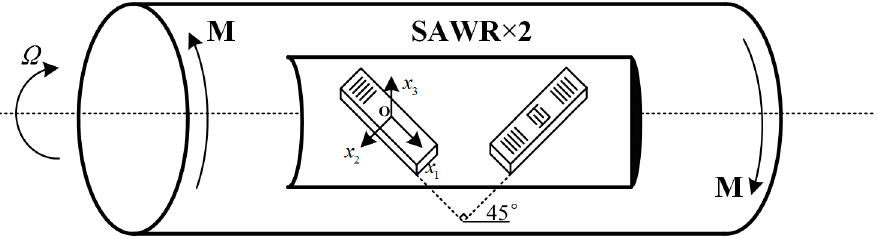
Figure 2. The SAW torque elements installation diagram.